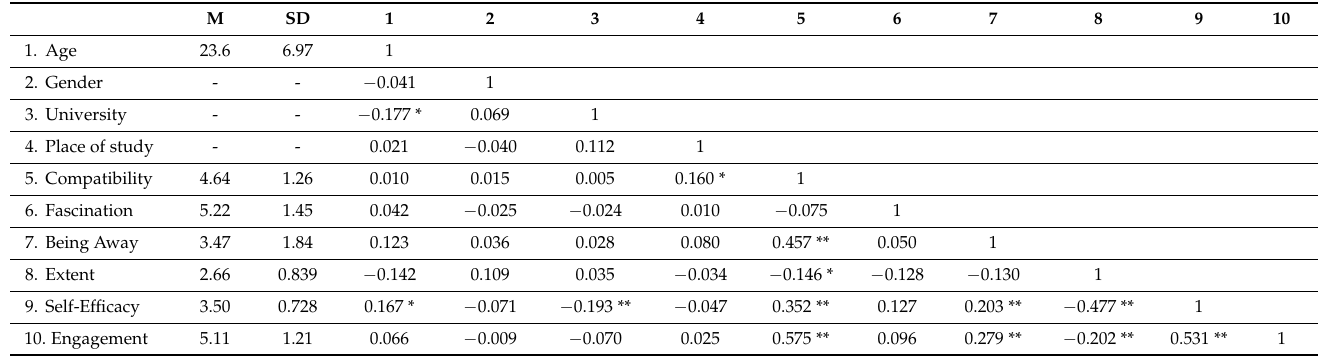
Table 1. Study Variables: Descriptive Statistics and Bivariate Correlations (N =